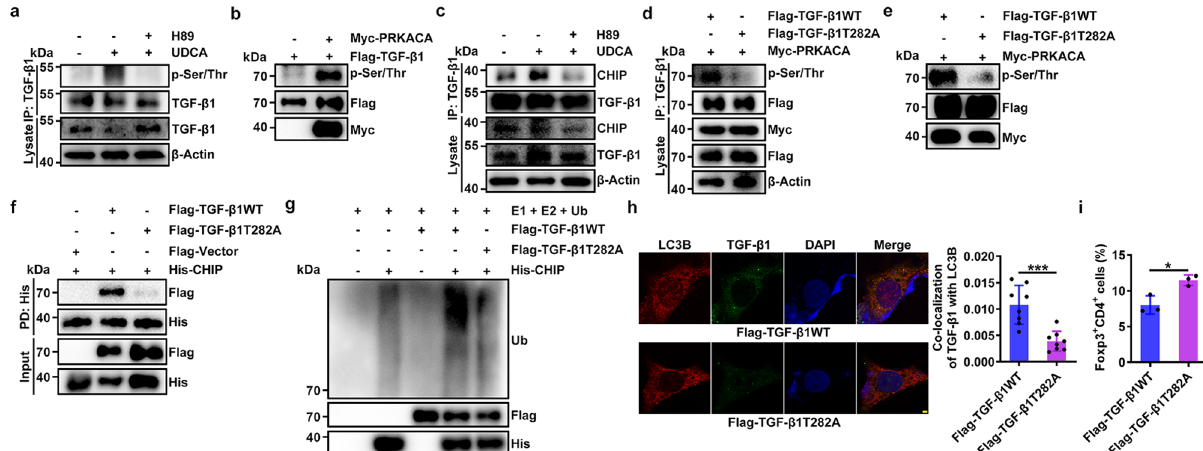
Fig. 5 The binding of TGF- β 1 phosphorylated at T282 by PKA to CHIP is increased. a IB analysis of Ser/Thr-phosphorylated TGF- β 1 in naïve CD4 + T cells stimulated with anti-CD3, anti-CD28 and 50 μ M UDCA and treated with or without 2 μ M H89 for 24 h. IB analysis was conducted after IP with anti- TGF- β 1. b IB analysis of assay mixtures containing Flag-TGF- β 1, Myc-PRKACA and ATP after reaction at 30 °C for 30 min in vitro. c IB analysis of CHIP and TGF- β 1 in naïve CD4 + T cells stimulated with anti-CD3, anti-CD28 and 50 μ M UDCA and treated with or without 2 μ M H89 for 24 h. IB analysis was conducted after IP with anti-TGF- β 1. d IB analysis of Ser/Thr-phosphorylated TGF- β 1 in HEK293T cells transfected with vectors expressing Flag-TGF- β 1WT, Flag-TGF- β 1T282A, and Myc-PRKACA for 24 h. e IB analysis of assay mixtures containing Flag-TGF- β 1 or Flag-TGF- β 1T282A plus Myc-PRKACA and ATP after reaction at 30 °C for 30 min in vitro. f IB analysis of TGF- β 1 in the mixture of His-CHIP and Flag-TGF- β 1WT and the mixture of Flag-TGF- β 1T282A after PD with anti-His magnetic beads. g IB analysis of TGF- β 1 ubiquitination in the presence of E1, E2, Ub, puri fi ed CHIP and TGF- β 1WT or TGF- β 1T282A. h , i Immuno fl uorescence analysis of LC3B and TGF- β 1 in HEK293T cells transfected with Flag-TGF- β 1WT or Flag-TGF- β 1T282A for 24 h. Scale bar, 2 μ m. ( h ) FC analysis of Foxp3 + CD4 + cells induced by culture with supernatants from these cells for 3 days ( i ). Representative results from two ( h ) or three ( a – g , i ) independent experiments are shown ( n = 8 in h ; n = 3 in i ). * P < 0.05; ** P < 0.01 (unpaired two-tailed Student ’ s t test; mean and s.d.). See Source Data fi le for the exact P